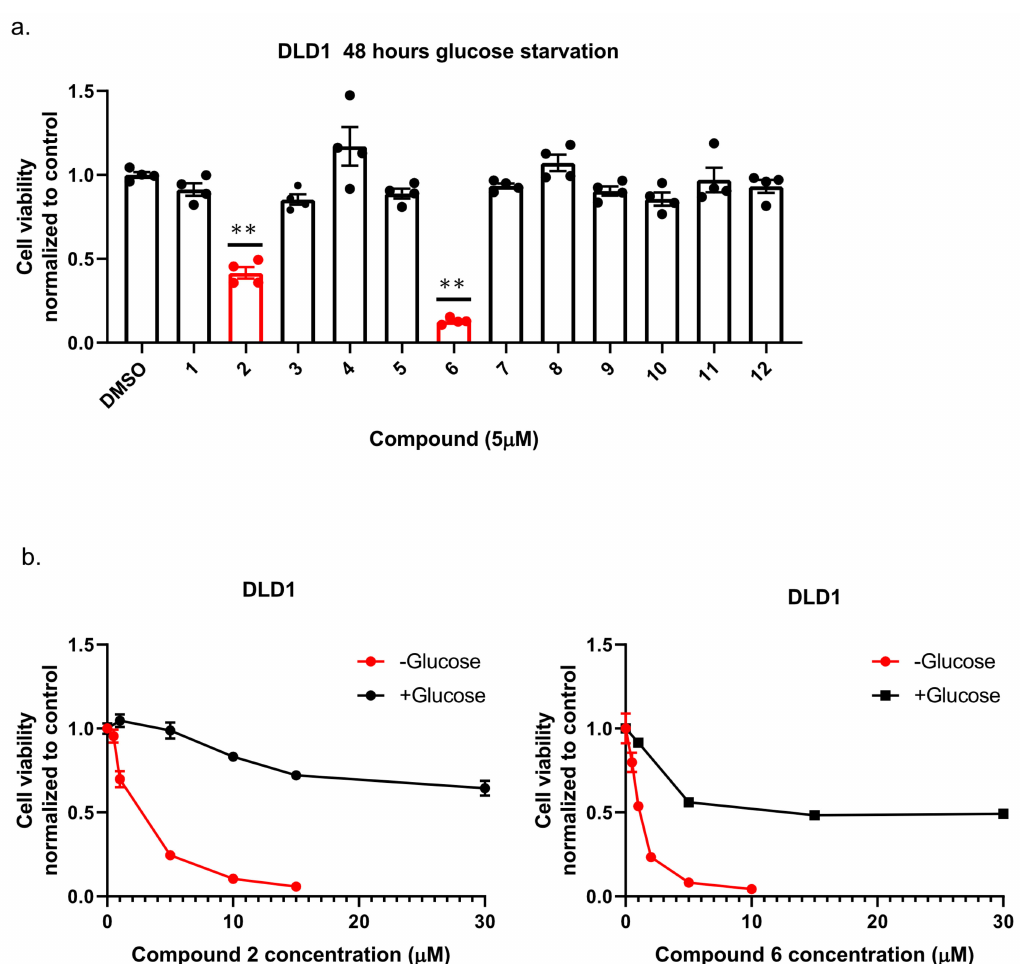
Figure 2. The selective toxicity of 12 amuvatinib derivatives under glucose starvation. ( a ) Bar graph showing relative cell viability of DLD1 tumor cell line treated with 5 µ M of compounds 1–12 for 48 h under glucose starvation was determined using Crystal Violet staining. Cell viability is relative to the control group (equal volume of dimethyl sulfoxide (DMSO)). Bars of compounds 2 and 6 are colored in red. ** p < 0.0001. ( b ) Kill curves of compounds 2 and 6 with and without glucose. Relative cell viability was measured using Crystal Violet after 48 h with and without